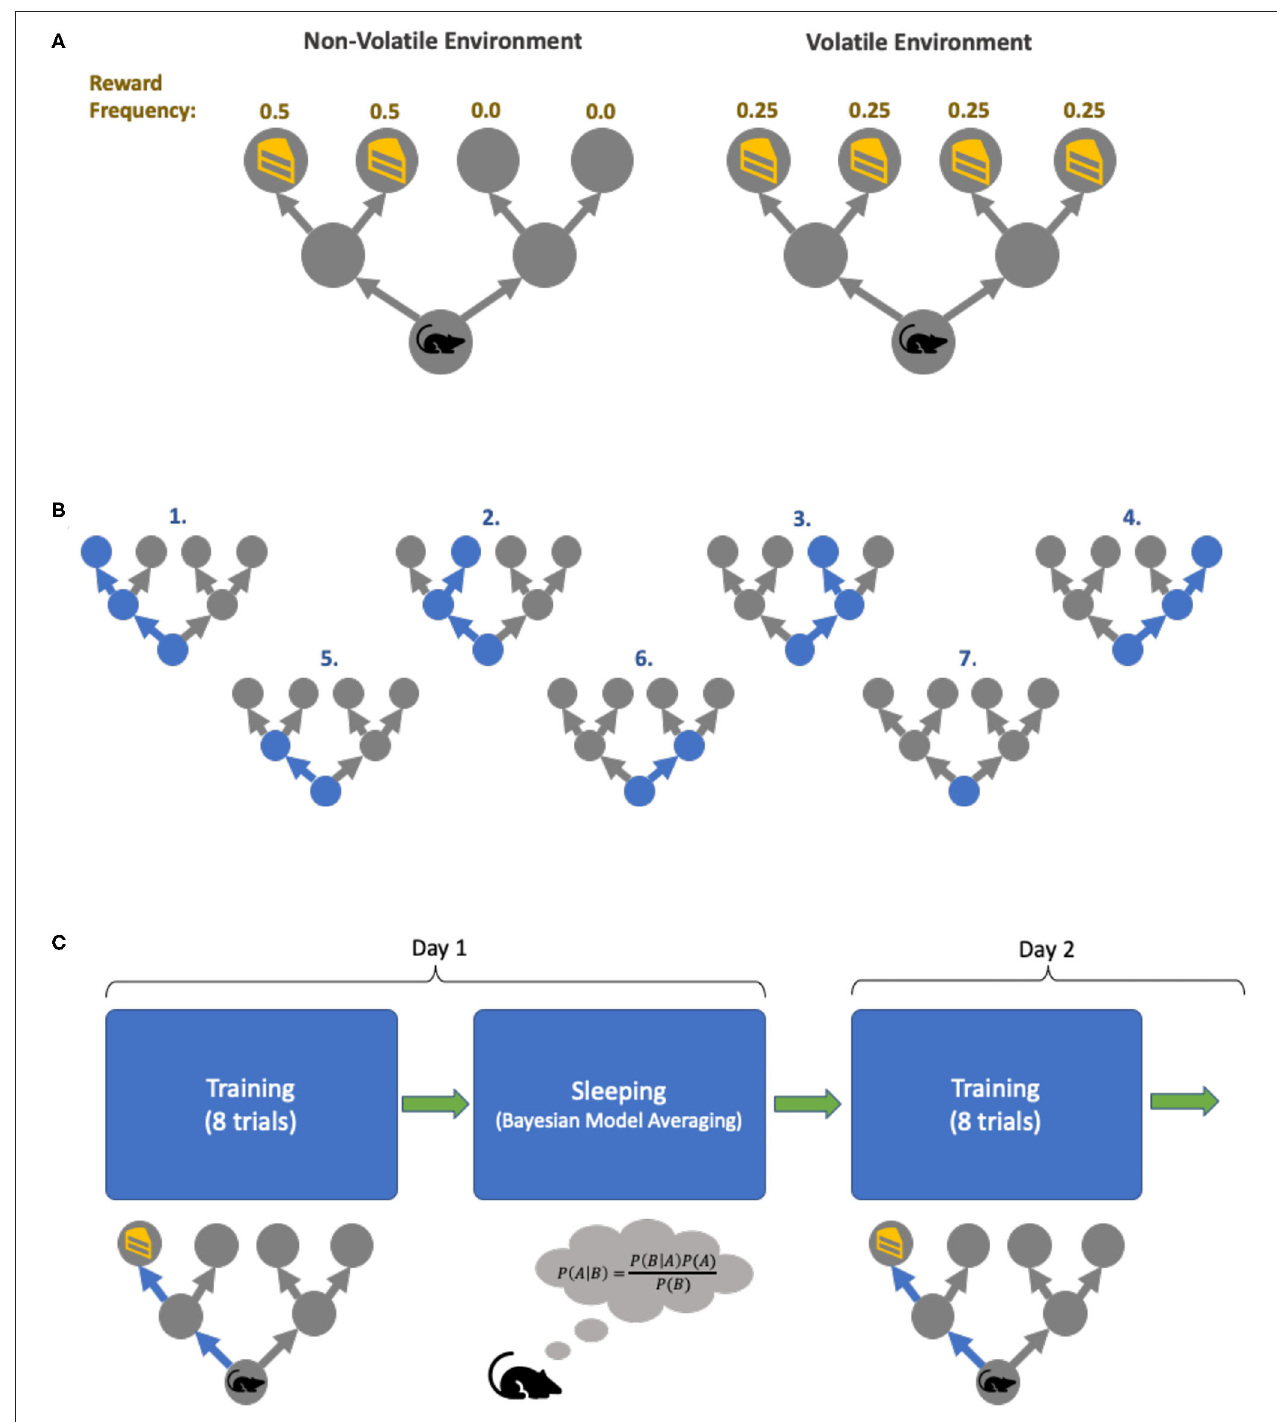
FIGURE 3 | Simulation task set-up. (A) The two environments in which the agents are trained. The environment can be non-volatile (left), in which the reward always appears on the left of the initial location, with equal frequency. The volatile environment (right) has reward appearing in all four final locations with equal frequencies. (B) The agent’s policies. In our simulation, our agents each have 7 policies it can pursue: the first four policies correspond to the agent going to one of the final locations, policies 5–6 has the agent going to one of the intermediate locations and staying there, and policy 7 has the agent not moving from its initial location for the entire duration of a trial. (C) The training cycles. Each day, each agent is trained for 8 trials in their respective environment, and in between days the agent goes to “sleep” (and perform Bayesian model averaging to find more optimal policy concentrations). This process is repeated for 32 days.